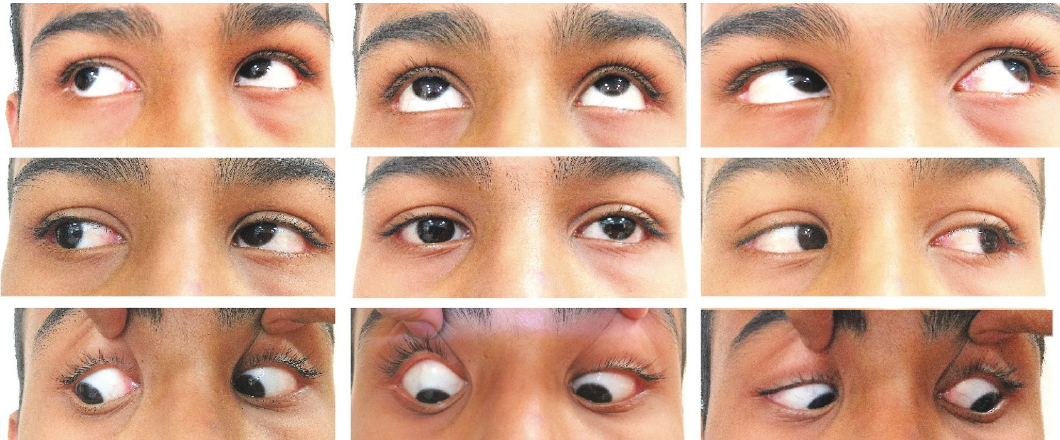
Figure 1: Clinical photograph of 9 cardinal gazes at